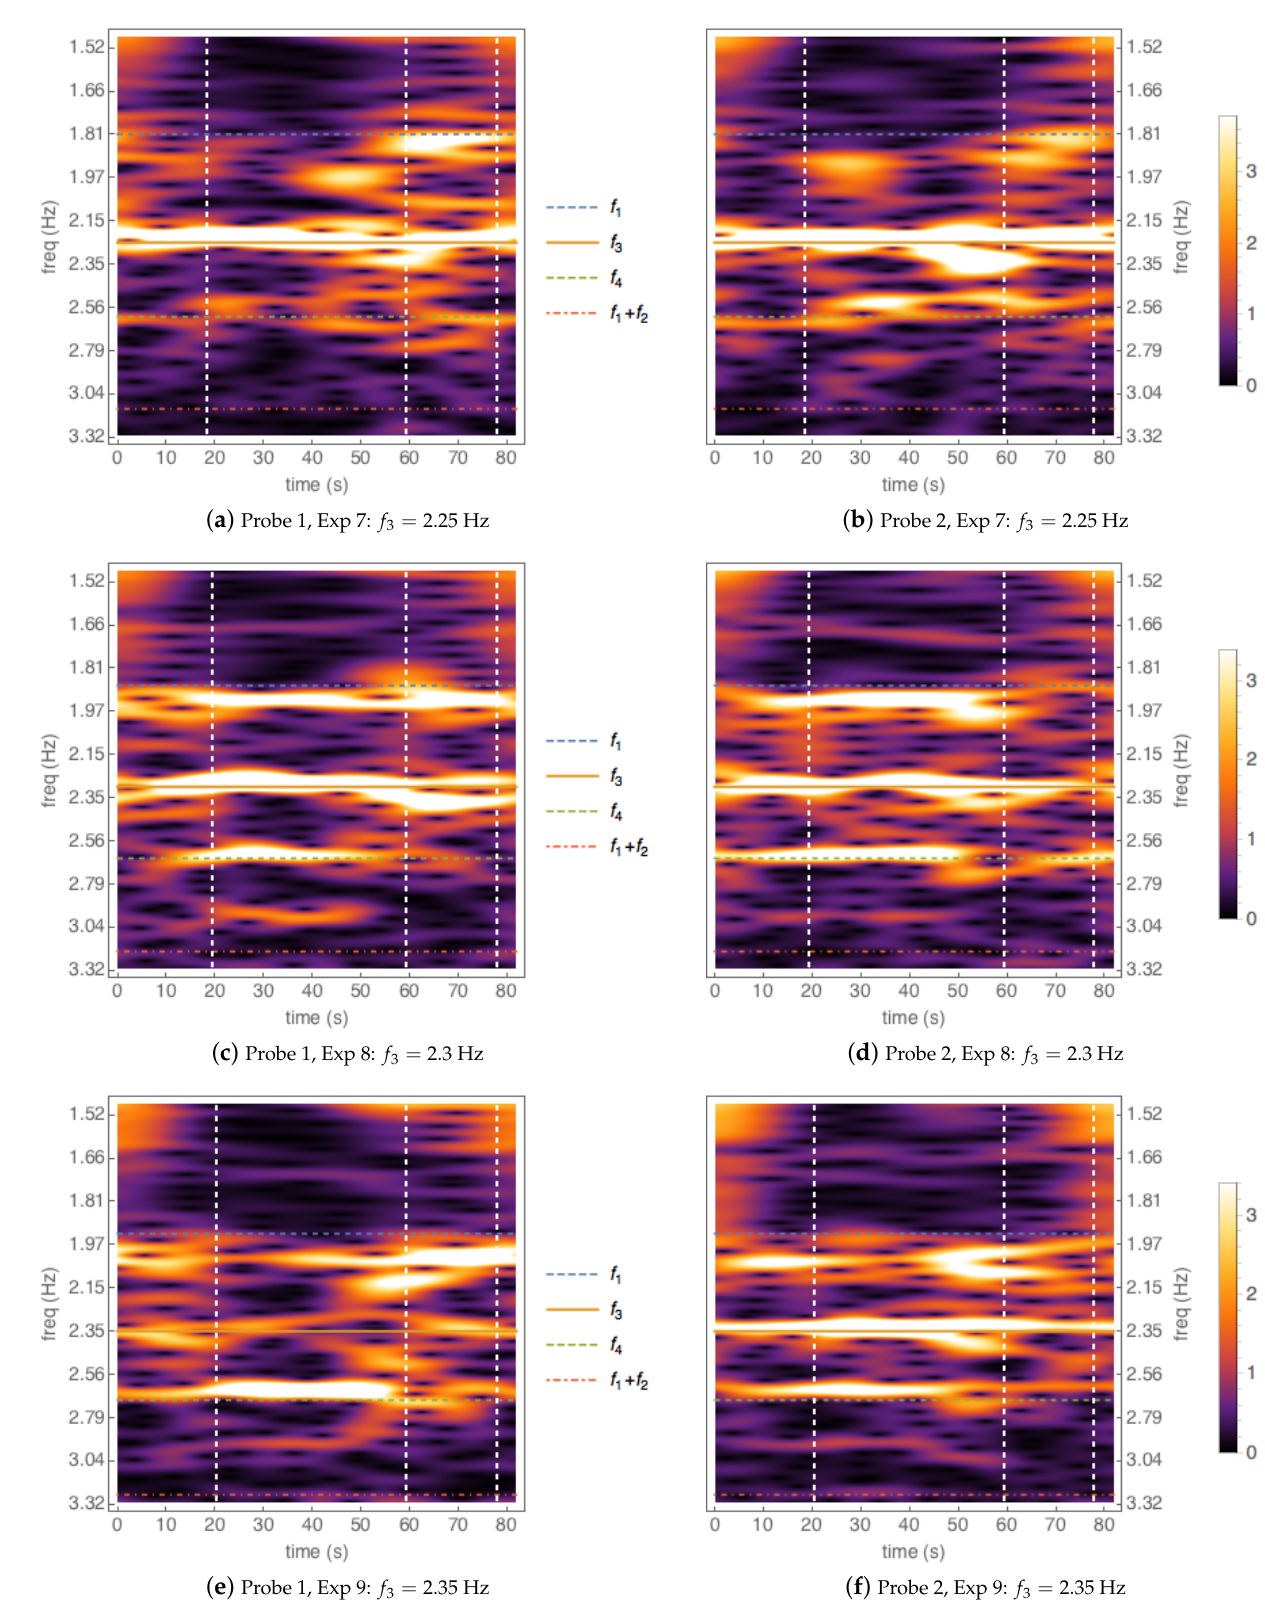
Figure 17. Same description as in the caption of Figure 15, but for experiments 7, 8 and 9, corresponding to f 3 / Hz = 2.25,2.3,2.35,